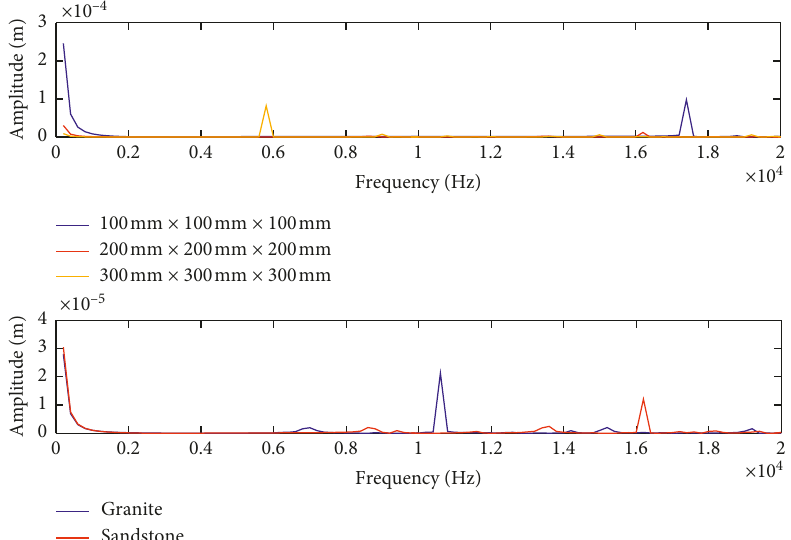
Figure 6: Resonance frequencies of rocks: (a) sandstones with the different volumes; (b) granite and sandstone with the same